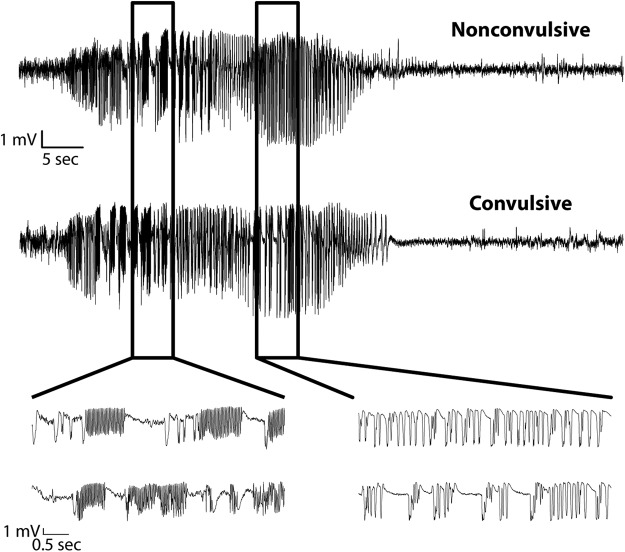
Interneuron ablation produces both convulsive and nonconvulsive seizures. Nonconvulsive and convulsive seizures were indistinguishable in the LFP recordings. The top and bottom seizures occurred ∼8 min apart in the same mouse. The first seizure (top) was associated with behavioral arrest and a gentle head nod side-to-side. The second seizure (bottom) was convulsive with forelimb clonus. Boxed regions are expanded below for both seizures to illustrate the similarities in waveforms during both high-frequency and large-amplitude periods of activity.